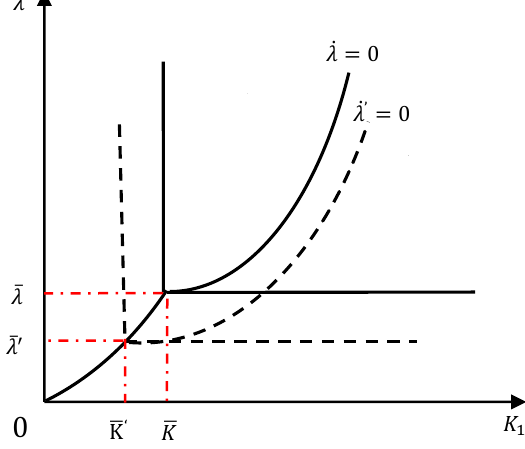
Figure 3. E ff ects of environmental investment on the developed Figure 3. Effects of environmental investment on the developed country.